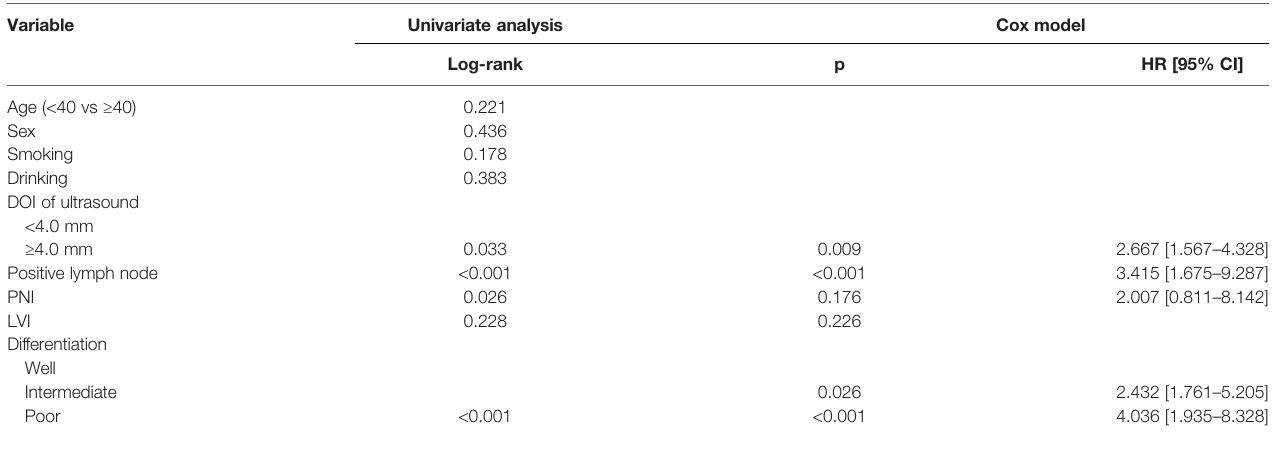
TABLE 4 | Univariate and cox model analyses of disease speci fi c survival in patients with ultrasound derived DOI ≥ 4.0 mm. Variable